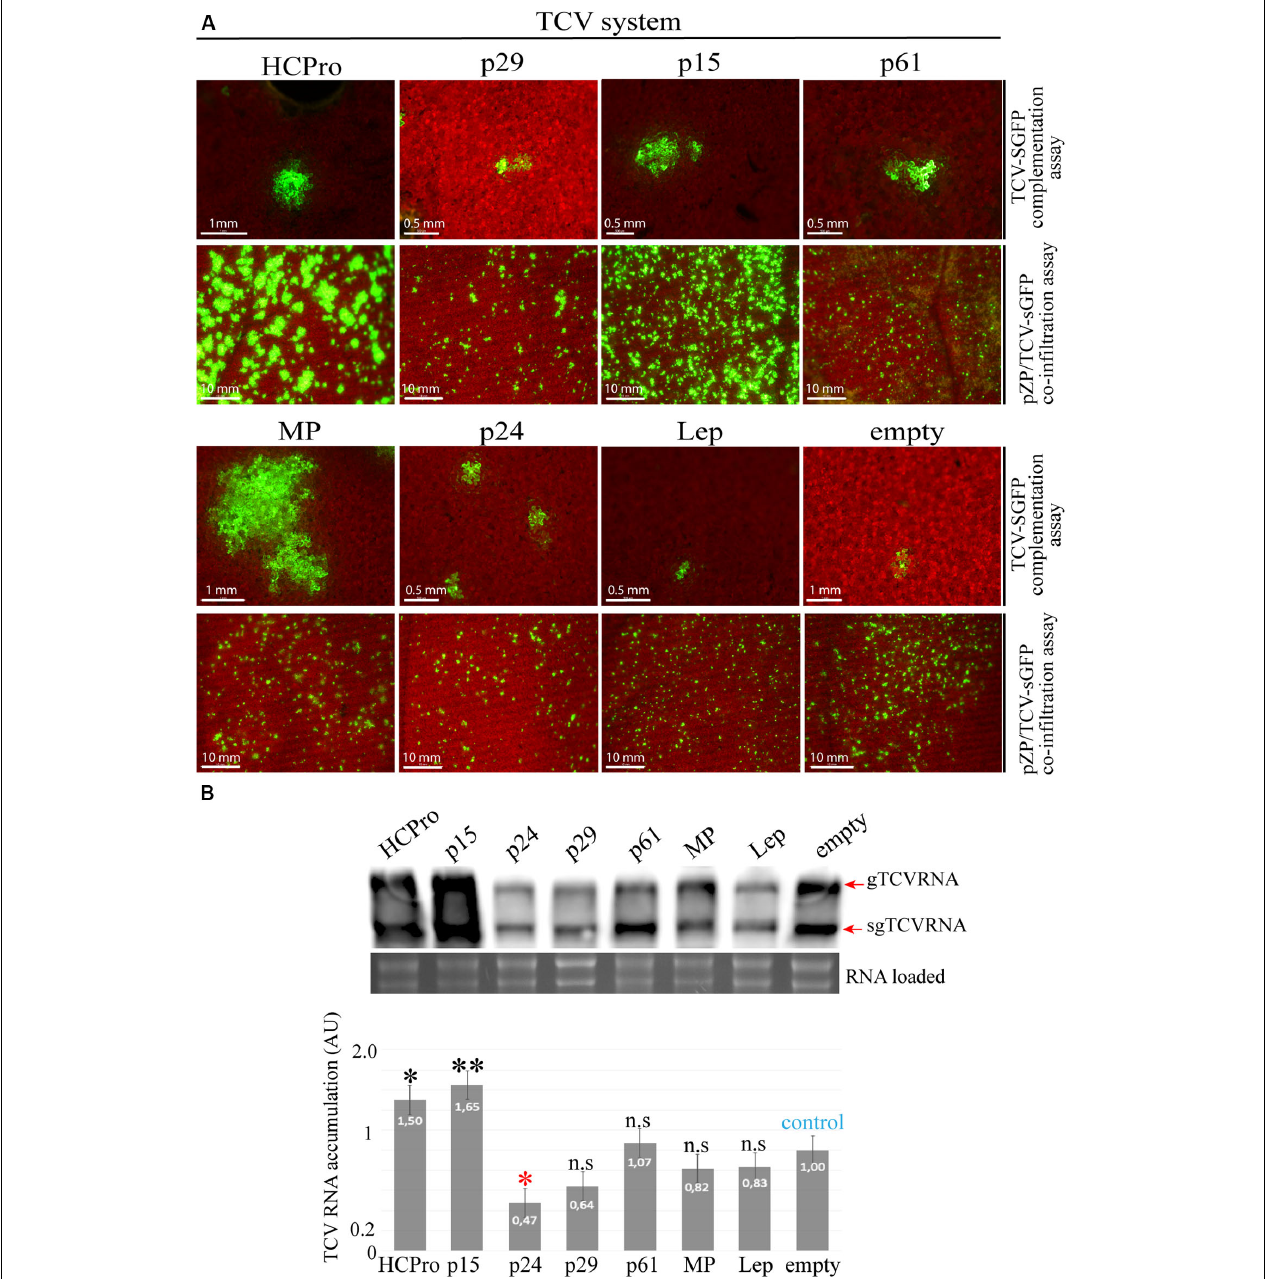
FIGURE 4 | The p15 protein complements the movement of an RSS defective turnip crinkle virus (TCV) mutant. (A) TCV assay based on the complementation or increment of fluorescence of the movement-deficiency phenotype of a TCV CP deletion mutant replaced by GFP (TCV-sGFP). For TCV-sGFP complementation assay, three N. benthamiana leaves per plant were infiltrated with pMOG 800 constructs carrying HCPro (positive control), p29, p15, p61, MP, p24, or pMOG-empty and pMOG-Lep as negative controls. Infectious RNA transcripts of the TCV-sGFP were mechanically inoculated 1 day post agroinfiltration. Cell-to-cell movement was evaluated at 3 dpi. For pZP/TCV-sGFP co-infiltration assay, pZP/TCV-sGFP was co-infiltrated with pMOG 800 empty and Lep (negative controls) or pMOG 800 carrying HCPro (positive control), p29, p15, p61, MP, and p24 CiLV-C genes. The increment of GFP fluorescence was monitored at 5 dpi. White bars correspond to 500 µ m–10 mm. (B) Northern blot analysis showing accumulation of TCV-sGFP genomic (gTCV) and subgenomic (sgTCV) RNAs, using a dig-riboprobe complementary to the TCV 3’UTR at 5 dpi. rRNA stained with ethidium bromide indicates equal loading of samples. The graph represents the relative accumulation of gTCV and sgTCV RNAs from three independent experiments. The value of the averages obtained from the band quantification was normalized in relation to the respective negative control (empty). The bands were quantified using ImageJ version 2.0cr software with ISAC plugin and error bars represent standard deviation. Statistical analyses were done using Student’s t -test. Black asterisks ( ∗ ) indicate significantly increased viral accumulation compared to the control, while red asterisks ( ∗ ) indicate significatively decreased viral accumulation. ∗∗ , p < 0.01; ∗ , p < 0.05; n.s, no significant difference. P -values were obtained from pairwise comparations between control vs. viral